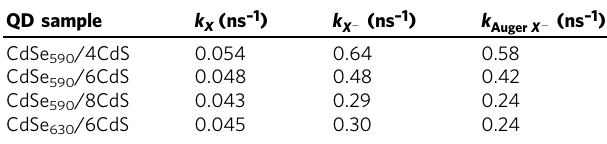
Table 1 Recombination rates of different channels for CdSe/ CdS QDs determined by the photochemical doping